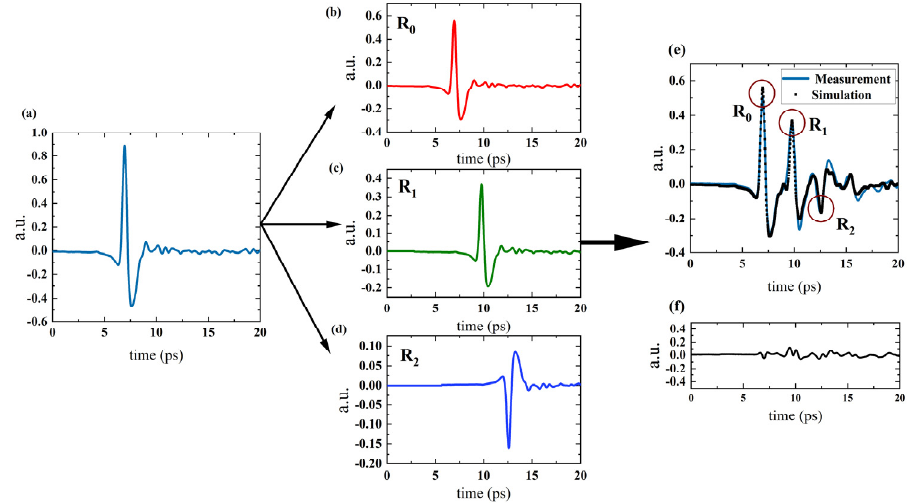
Figure 4. ( a ) The used reference signal obtained by reflective THz experimental platform; ( b ) Simulated signal of R 0 (the surface reflection); ( c ) Simulated signal of R 1 (the first interface reflection); ( d ) Simulated signal of R 2 (the second interface reflection); ( e ) Comparison between the simulated result and the experimental result; ( f ). The difference between the two signals.